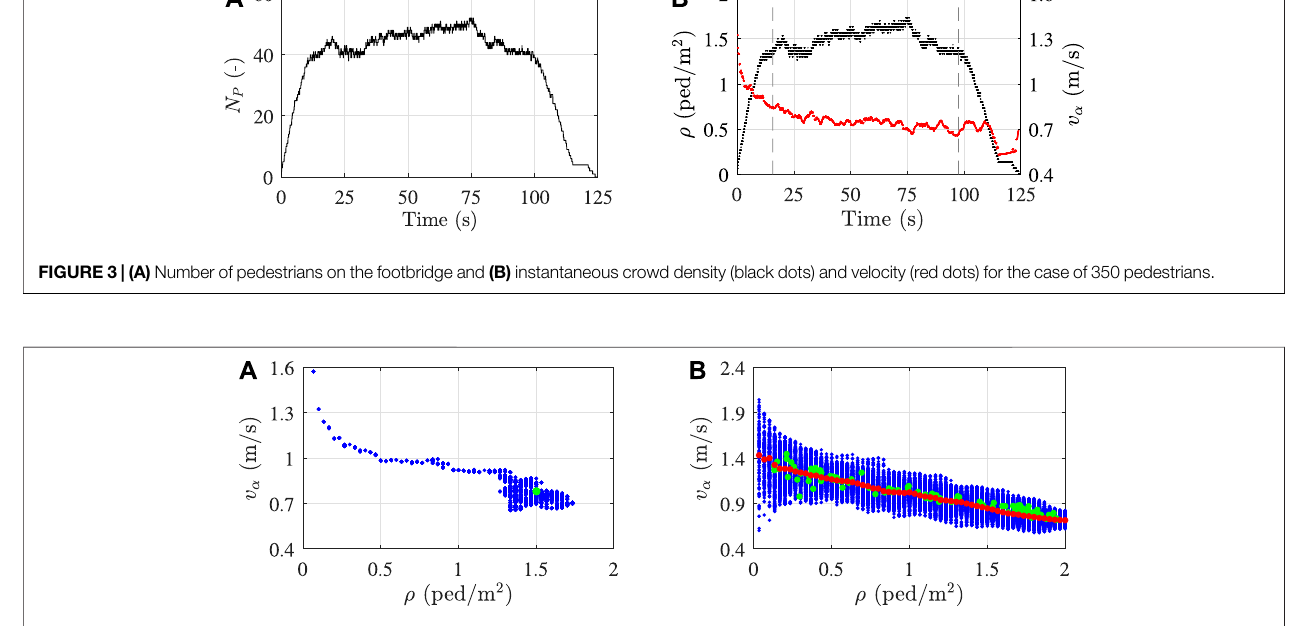
FIGURE 4 | (A) Example of the crowd density and velocity from criterion 1 (blue dots) and criterion 2 (green dot) for the case of 350 pedestrians (B) example of the crowd density and velocity from criterion 1 (blue dots) and criterion 2 (green dots) and simulated speed-density relation (red dots) for group dimensions from 25 to 500